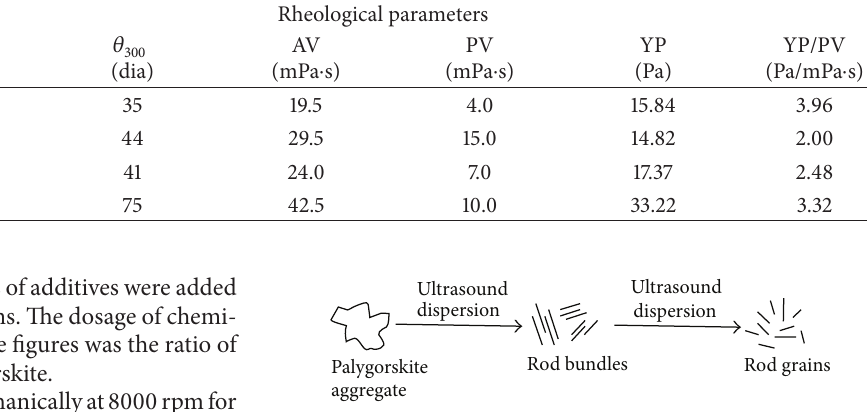
Table 2: The effect of pressing on the rheological parameters of palygorskite suspension.